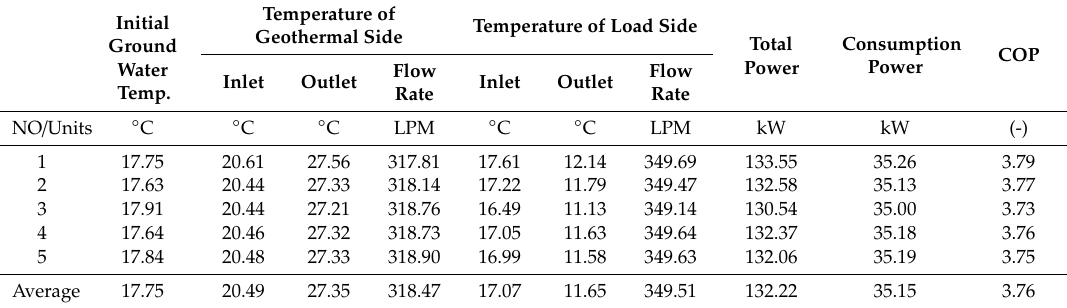
Table 4. Measured results of the BW SCW geothermal system cooling operation. Initial